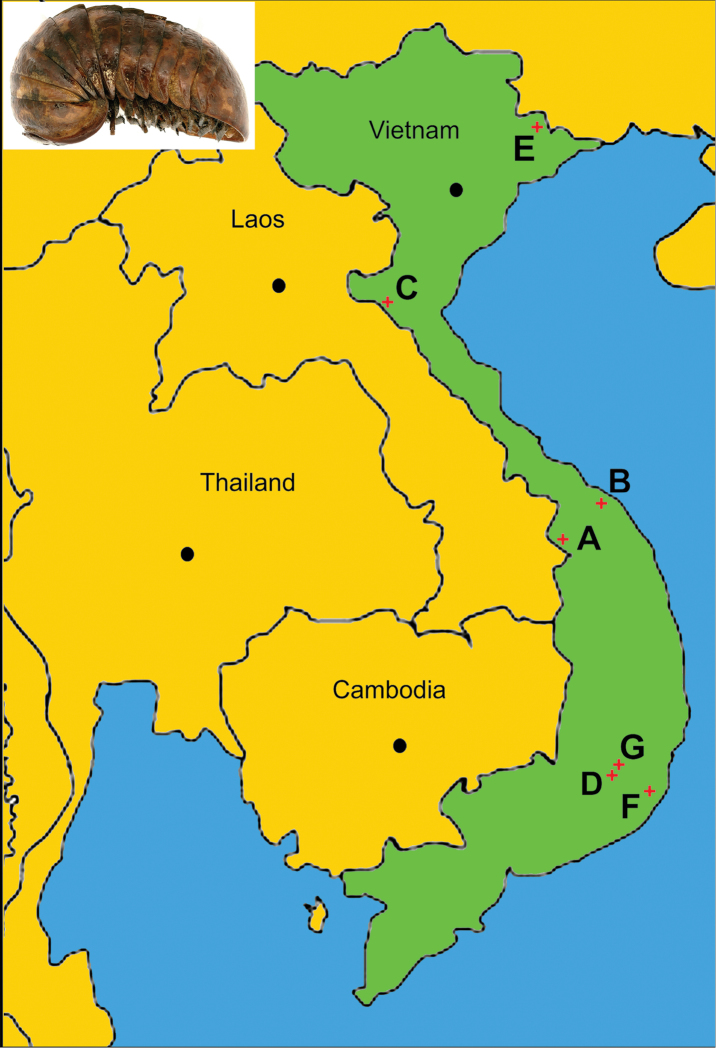
Habitus photograph of the lectotype (HNHM 2858/1) of Sphaeropoeus
maculatus (Verhoeff, 1924), lateral view, and a distribution map of all other relevant zephroniid species in Vietnam. ASphaerobelum
bicorne Attems, 1938 (new record) BSphaerobelum
bicorne Attems, 1938 (old record) CSphaerobelum
pumatense sp. nov. DSphaeropoeus
manca (Attems, 1936) ESphaeropoeus
maculatus (Verhoeff, 1924) FSphaeropoeus
honbaensis sp. nov. GSphaeropoeus
bidoupensis sp. nov.